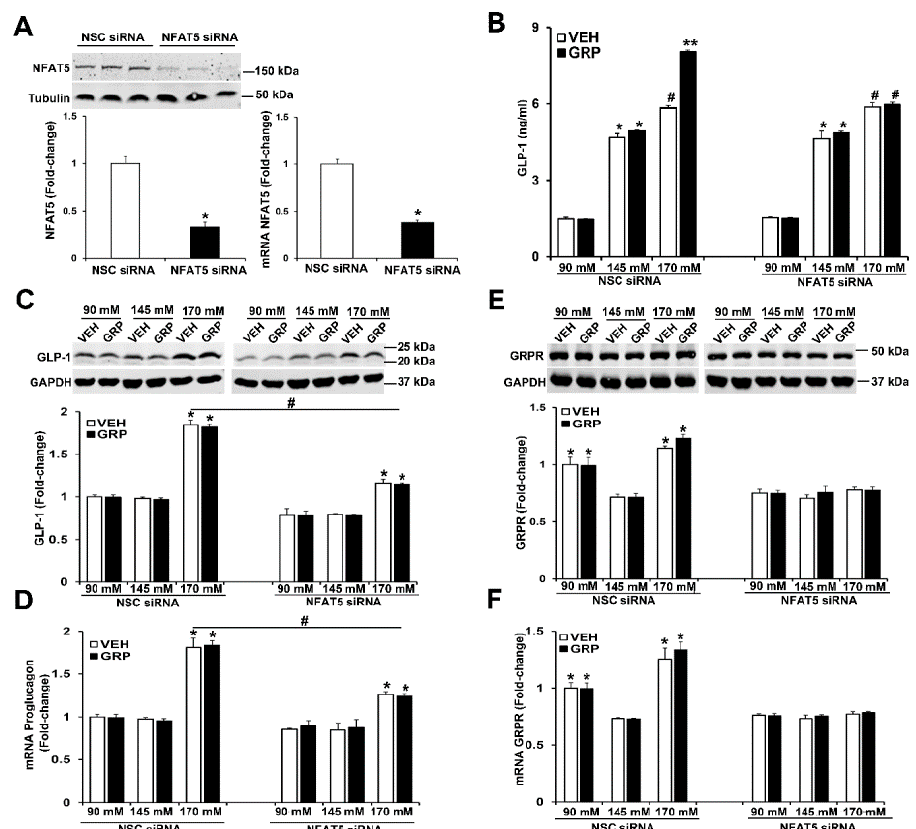
Figure 5. Silencing NFAT5 minimizes the high sodium-induced increase in GLP-1 secretion and blocks the sodium-induced increase in GRPR expression in human L-cells. ( A ) The same quantity of L-cells was transfected with NFAT5 siRNA or non-silencing (NSC) siRNA. Forty-eight hours after transfection, NFAT5 protein or NFAT5 mRNA was quantified by immunoblotting or RT-qPCR, respectively. Tubulin was used for normalization of the data. Quantifications were finally expressed as fold-change over the NSC siRNA group. n = 3/group, * p < 0.05 vs. NSC siRNA, t -test ( B ) the secretion of GLP-1 was quantified by ELISA in the incubation medium of L-cells. n = 3/group, * p < 0.05 vs. 90 mM. # p < 0.05 vs. 90 mM or 145 mM, ** p < 0.05 vs. others. ( C ) Protein or ( D ) mRNA expression of GLP-1 in human L-cells was quantified by immunoblotting or RT-qPCR, respectively. GAPDH was used for normalization of the data. Quantifications were finally expressed as fold-change over the NSC siRNA 90 mM group. n = 3/group. * p < 0.05 vs. 90 mM or 145 mM. # p < 0.05 NSC siRNA 170 mM vs. NFAT5 siRNA 170 mM. ( E ) Protein or ( F ) mRNA expression of GRPR in human L-cells was quantified by immunoblotting or by RT-qPCR, respectively. GAPDH was used for normalization of the data. Quantifications were finally expressed as fold-change over the NSC siRNA 90 mM group. n = 3/group. * p < 0.05 vs. 145 mM. One-way ANOVA, Holm–Sidak test. VEH = vehicle.